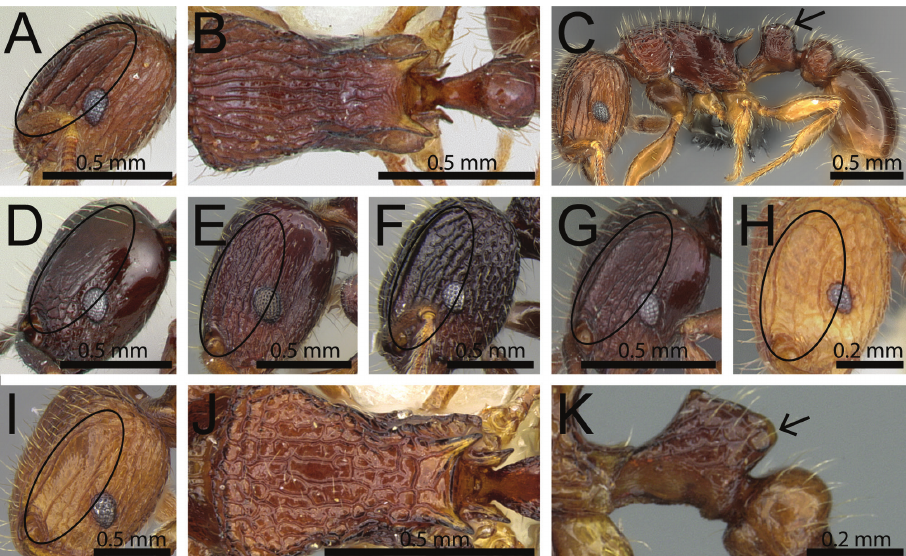
Figure 17. Head (without mandibles) in profile (antennal scrobe area within black ellipses); mesosoma in dorsal view; body and waist segments in profile. A, B T. plesiarum (CASENT0172831) C T. mars (CASENT0474279) D T. silvicola (CASENT0042828) E T. nassonowii (CASENT0195504) F T. ad- amsi (CASENT0247296) G T. dysalum (CASENT0102348) H, J, K T. zenatum (CASENT0102355; CASENT0344941) I T. fhg-vazi